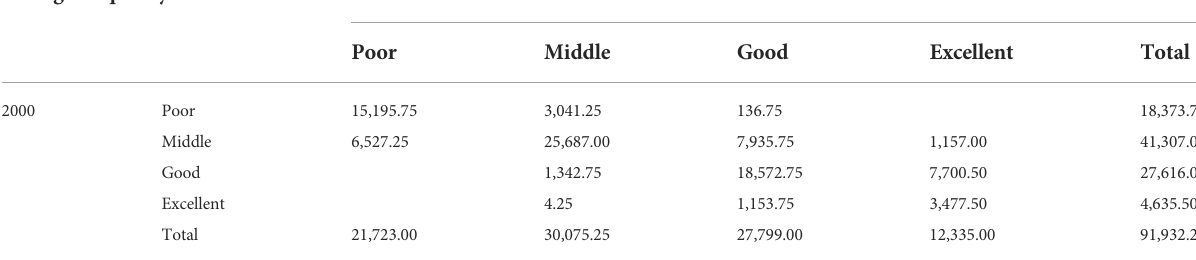
TABLE 2 Area transfer matrix of different ecological quality grades in Tarim River Basin from 2000 to 2021 Unit/km 2 . Ecological quality